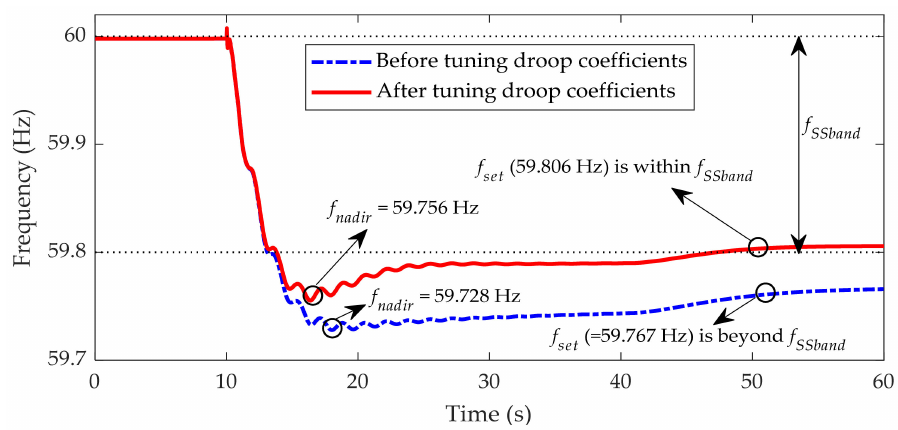
Figure 10. Results of system frequency for case study 1.